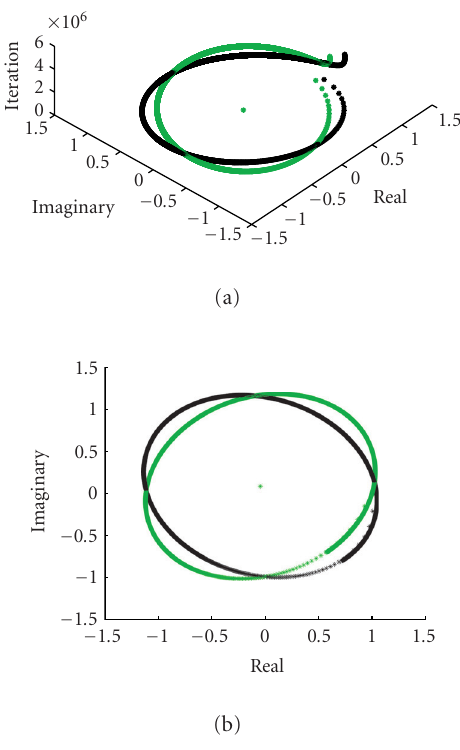
Figure 2.1. Dynamics for cycles of length c = 1. Shown are the iterates v n given by (2.1) with a n = exp( iπ/ 2) for all n . Odd iterates are light, even iterates are